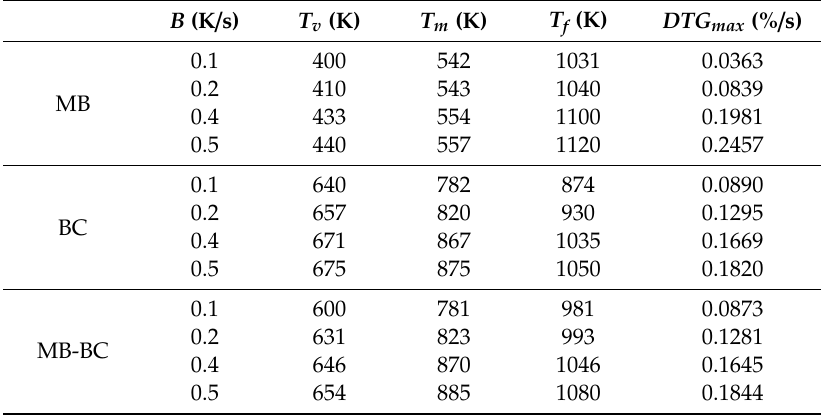
Table 5. Characteristic parameters of DTG combustion curves determined for microalgae biomass (MB), bituminous coal (BC) their blend